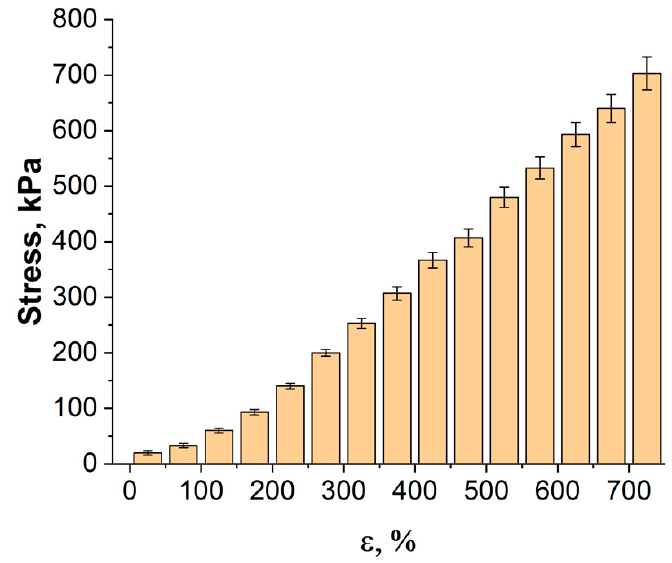
Figure 8. Diagram of applied tensile load of elongation of sensor.